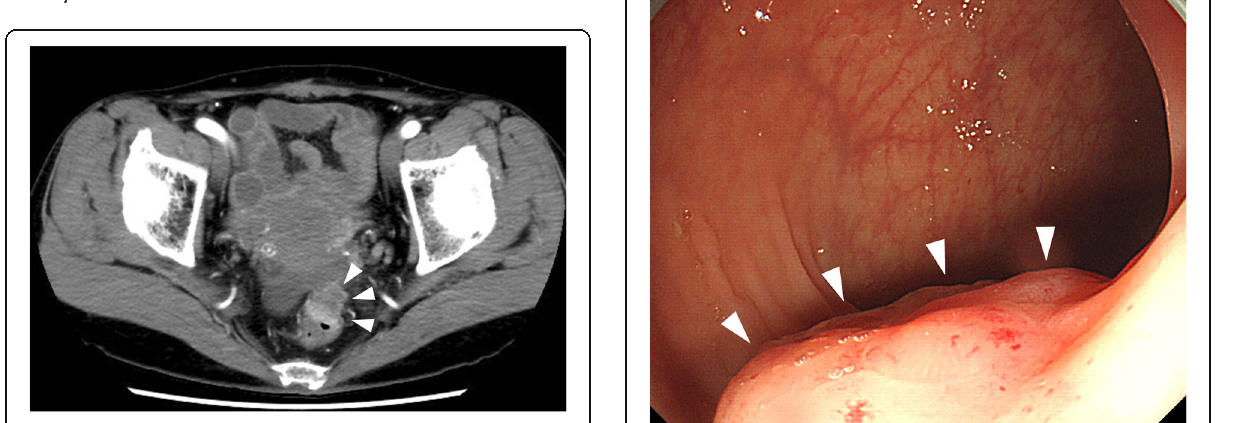
Fig. 1 Computed tomography scan of the patient ’ s abdomen and pelvis showing a tumor 20 mm in size along the middle rectal wall and expanding into the pelvis (arrowhead)